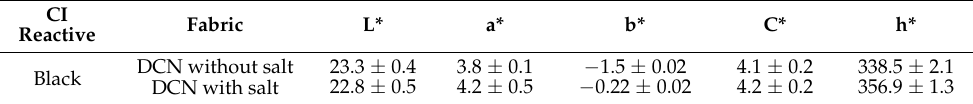
Table 3. Color attributes of the fibers colored with and without the presence of salt.